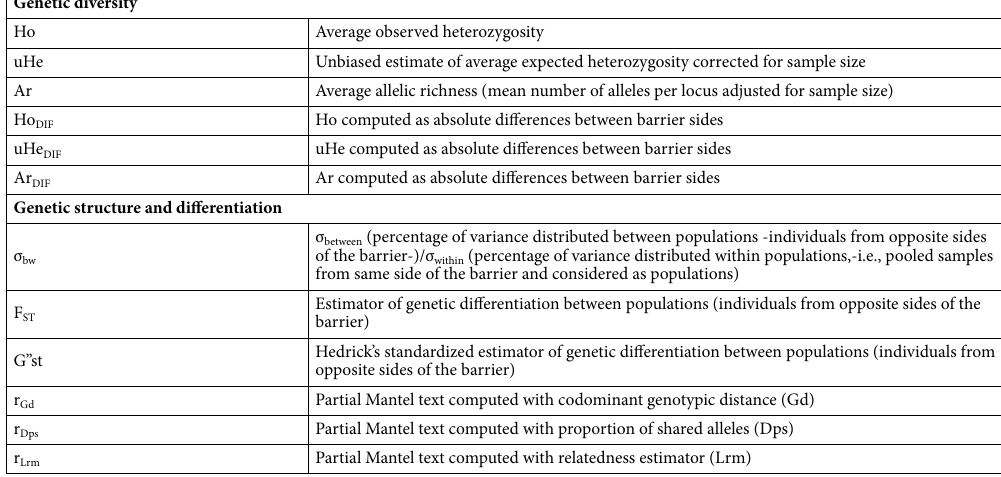
Table 2. Variables used in the study to describe genetic diversity, structure and differentiation of common vole.